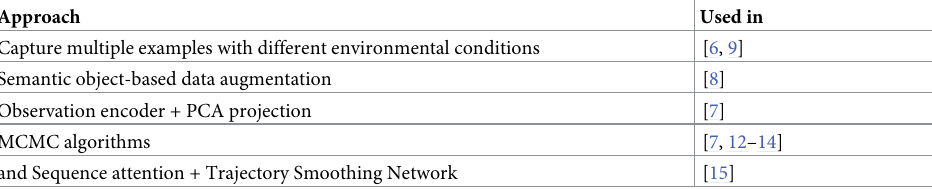
Table 3. An overview of the temporal awareness approaches used in cross-view geo-localization.